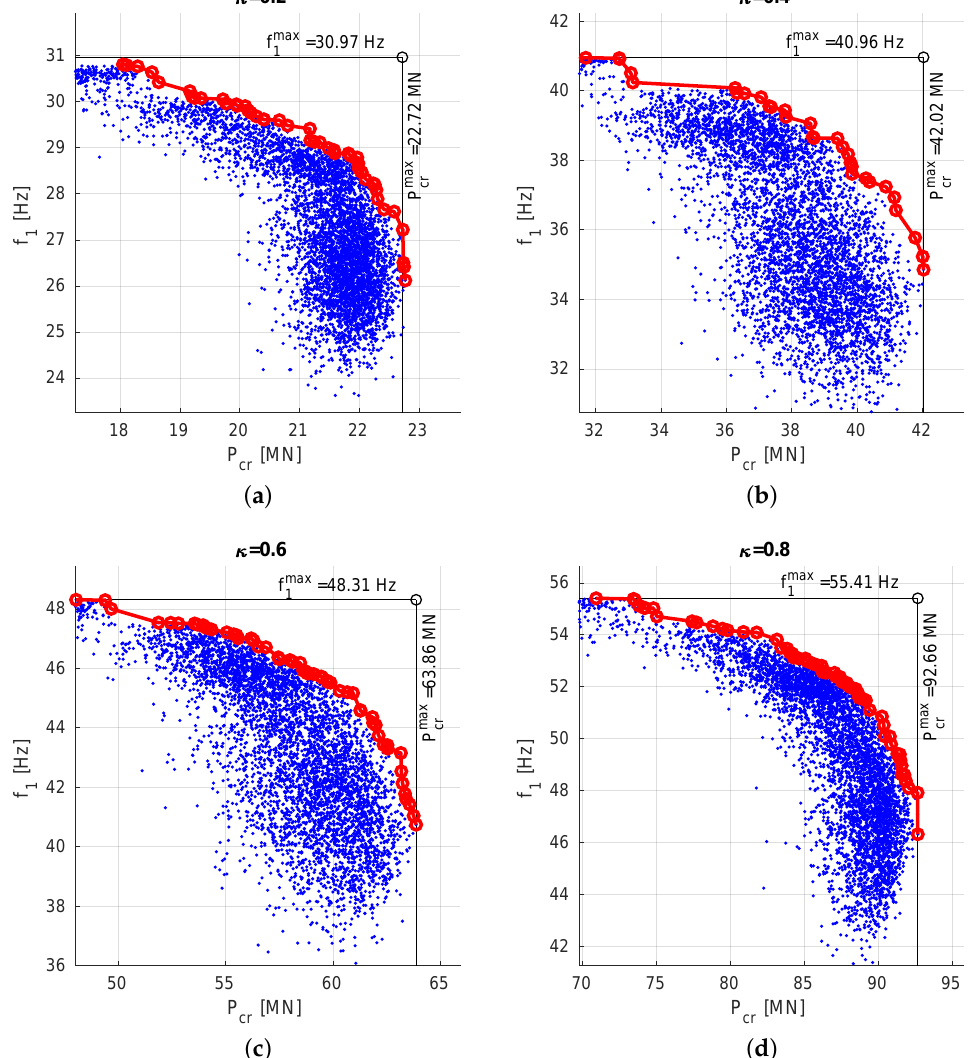
Figure 12. The results of f 1 and P cr optimization, obtained for different values of coefficient κ , ( a ) κ = 0.2, ( b ) κ = 0.4, ( c ) κ = 0.6, ( d ) κ =